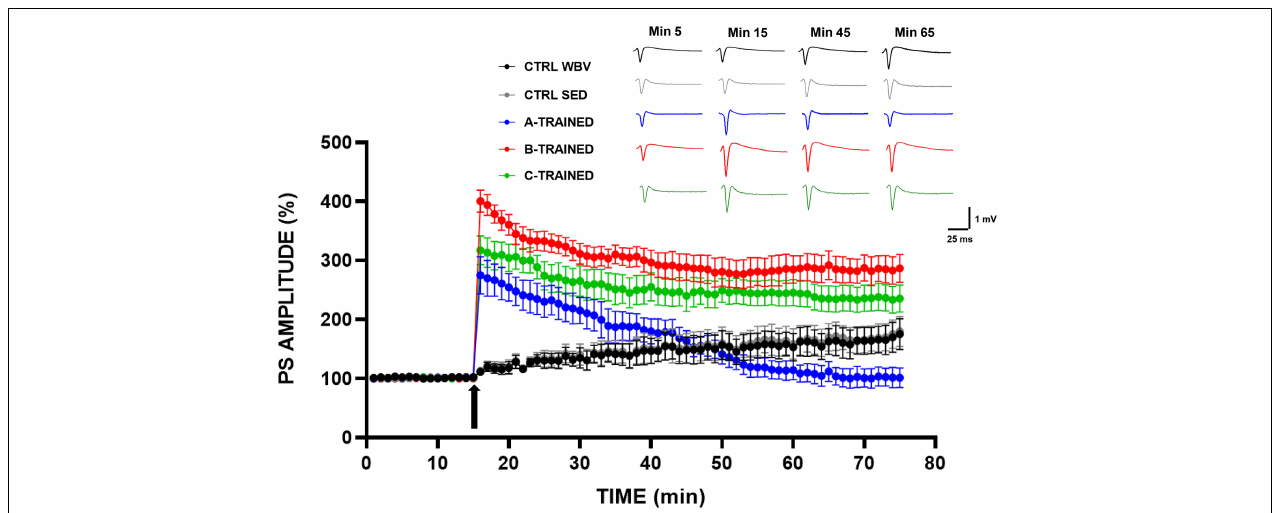
FIGURE 1 | Synaptic plasticity in CA1 hippocampal subfield of old mice.% population spike (PS) amplitude as a function of time after HFS, applied at time t = 15 (arrow), is shown in CTRL WBV (black line, n = 7), in CTRL SED (gray line, n = 7), in A-TRAINED (blue line, n = 7), in B-TRAINED (red line, n = 8), and in C-TRAINED (green line, n = 9) mice slices. The insert shows representative recordings obtained from slices of each experimental group; the curves of each group refer to population spike at times 5, 15, 45, and 65